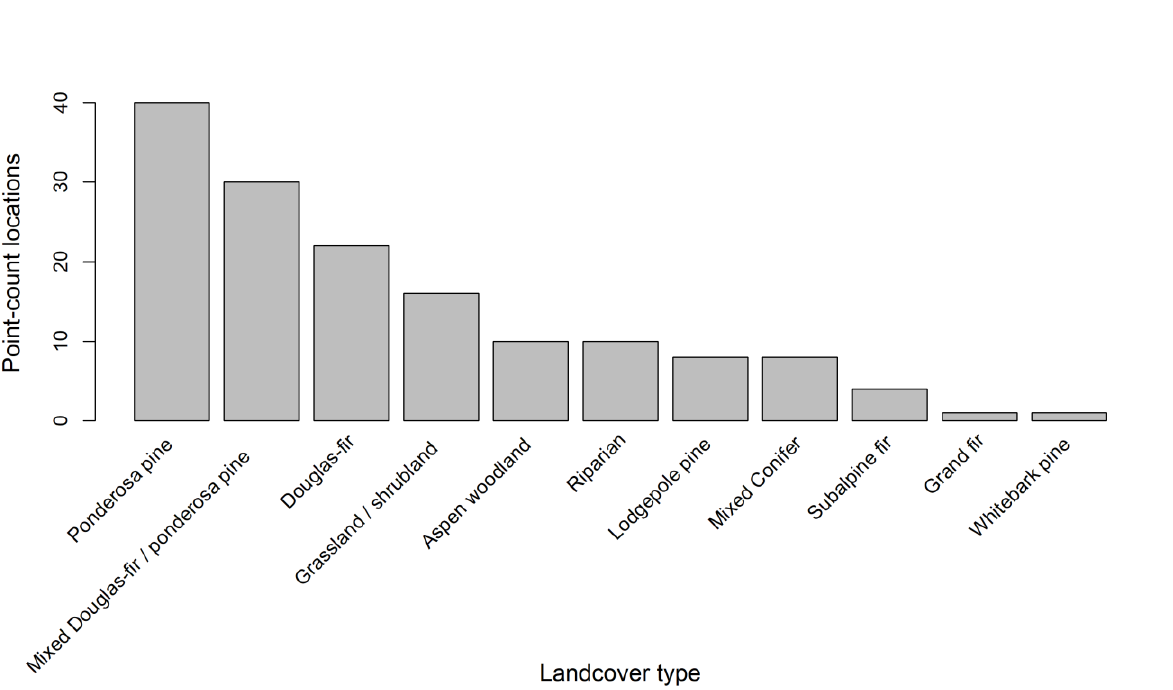
Figure A1.1. Landcover type at point-count locations (n = 150) within the Boise National Forest, Idaho, U.S.A. described using the southwest LANDFIRE (2013) database.